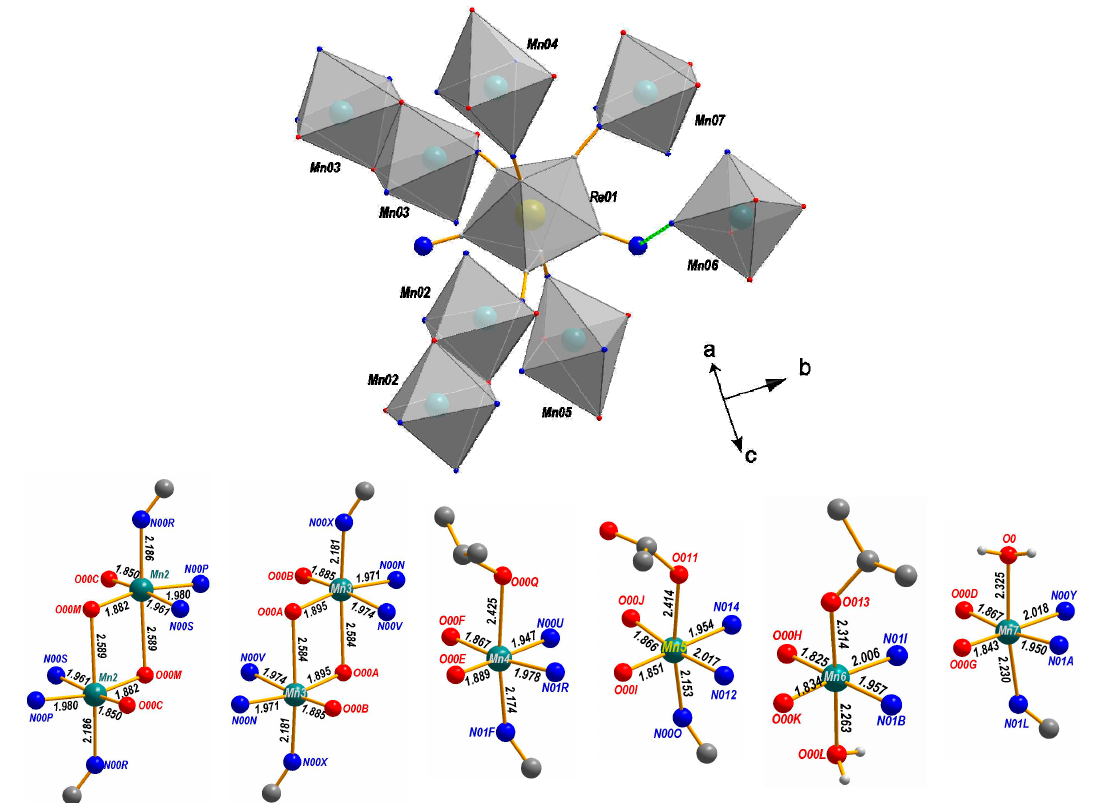
Figure 7. Coordination polyhedra in 5 . The equatorial planes of the axially elongated octahedrons are composed of {OONN} atom set of SB ligand. The duplicated Mn2 and Mn3 polyhedra show the direction of 1D assembly.